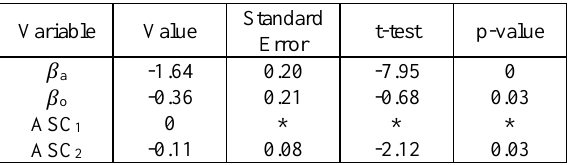
Table 8. DCM Results for scenario 3